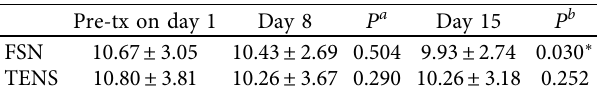
Table 7: Effectiveness of FSN and TENS groups on sleep quality via self-reported PSQI